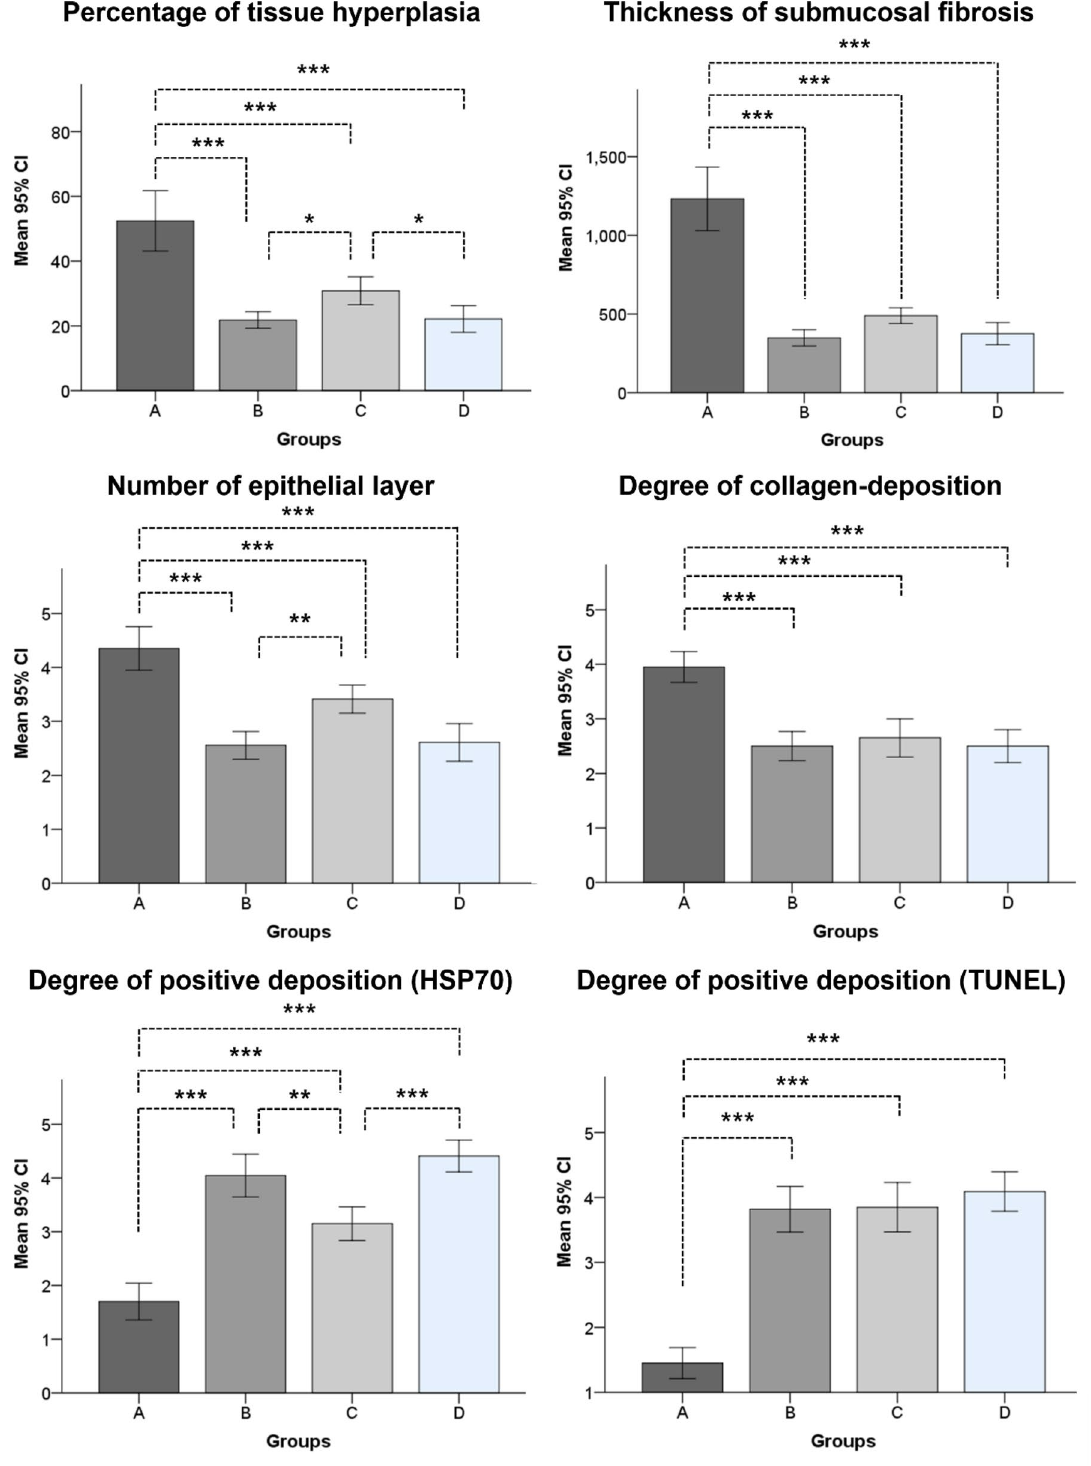
Figure 5. Histopathological findings for the stented rat esophagus at 4 and 8 weeks after stent placement in groups ( A - D ); * p < 0.05, ** p < 0.01, *** p <